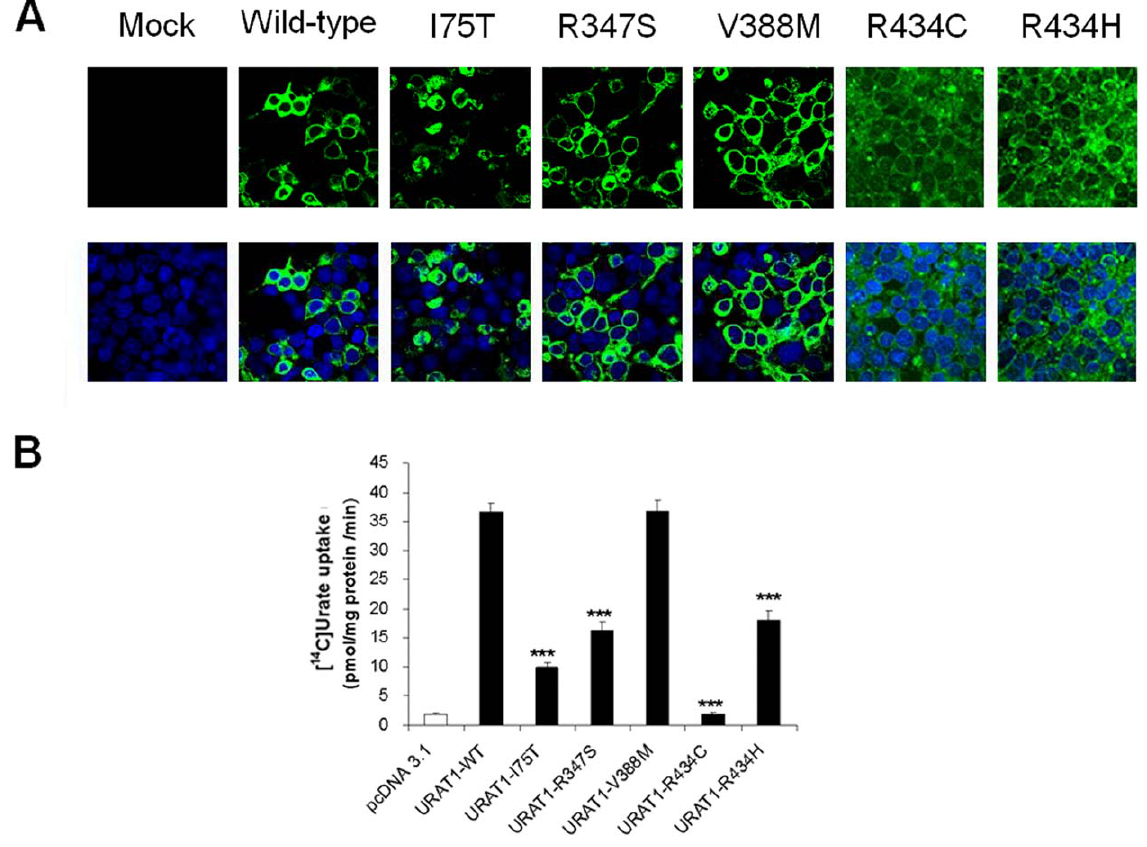
Figure 2. Functional analysis of changes in URAT1 expressed in HEK293 cells. A. HEK293 cells were transiently transfected with Flag-tagged URAT1 cDNA constructs (wild-type and variants I75T, R347S, V388M, R434C and R434H). Plasma membrane expression was detected using an anti- FLAG monoclonal antibody, secondarily detected using an Alexa Fluor H 488 (green) antibody. Nuclei are counter stained using DAPI (blue). B. Uric acid uptake by HEK293 cells transiently transfected with wild-type URAT1 or its mutants was measured using [ 14 C]Urate at 2 min, at 37 u C and pH7.4. Significant reductions in urate transport activity was seen in some of the disease-associated variants. Data are mean 6 S.E.M with n=4. ***, P , 0.001 when compared with wild type.